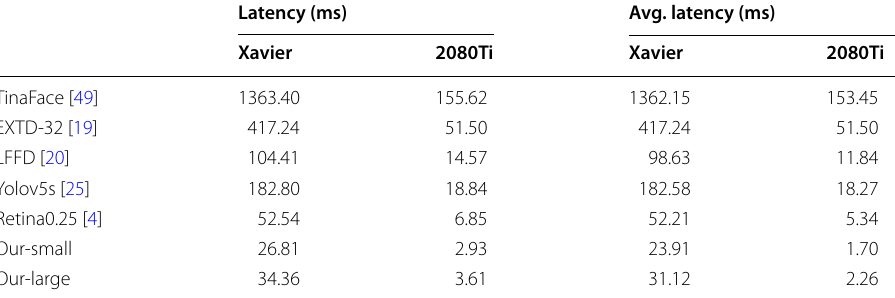
Table 3 Inference latency comparison with 4K resolution image on GPU and Jetson Xavier